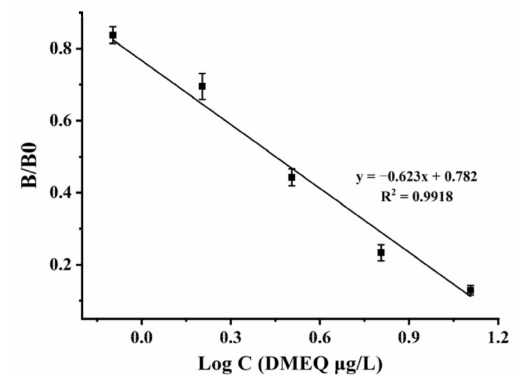
Figure 4. The standard curve of